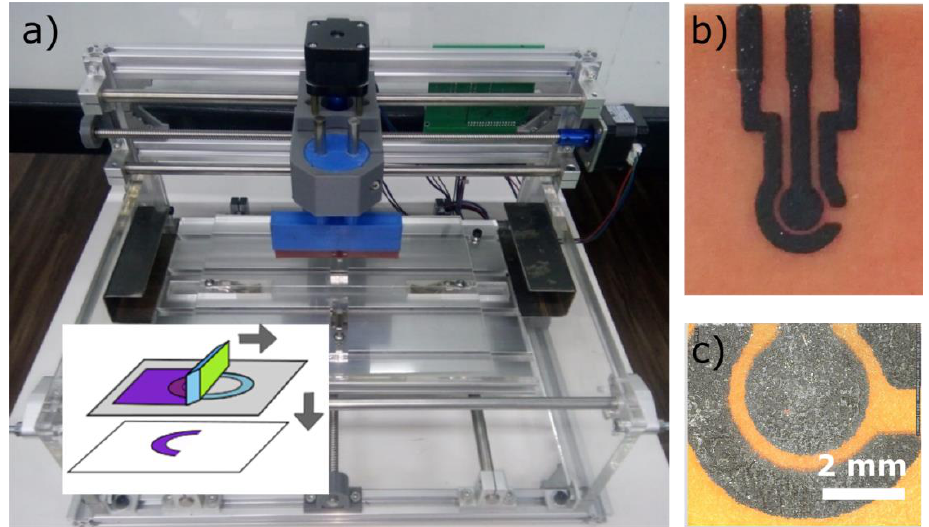
Figure 6. Screen printing. ( a ) Screen printing device and principle of operation (inset). ( b , c ) carbon- Figure6. Screenprinting. ( a )Screenprintingdeviceandprincipleofoperation(inset). ( b , c )carbon-based based electrode deposited using screen printing at two magnifications. electrode deposited using screen printing at two